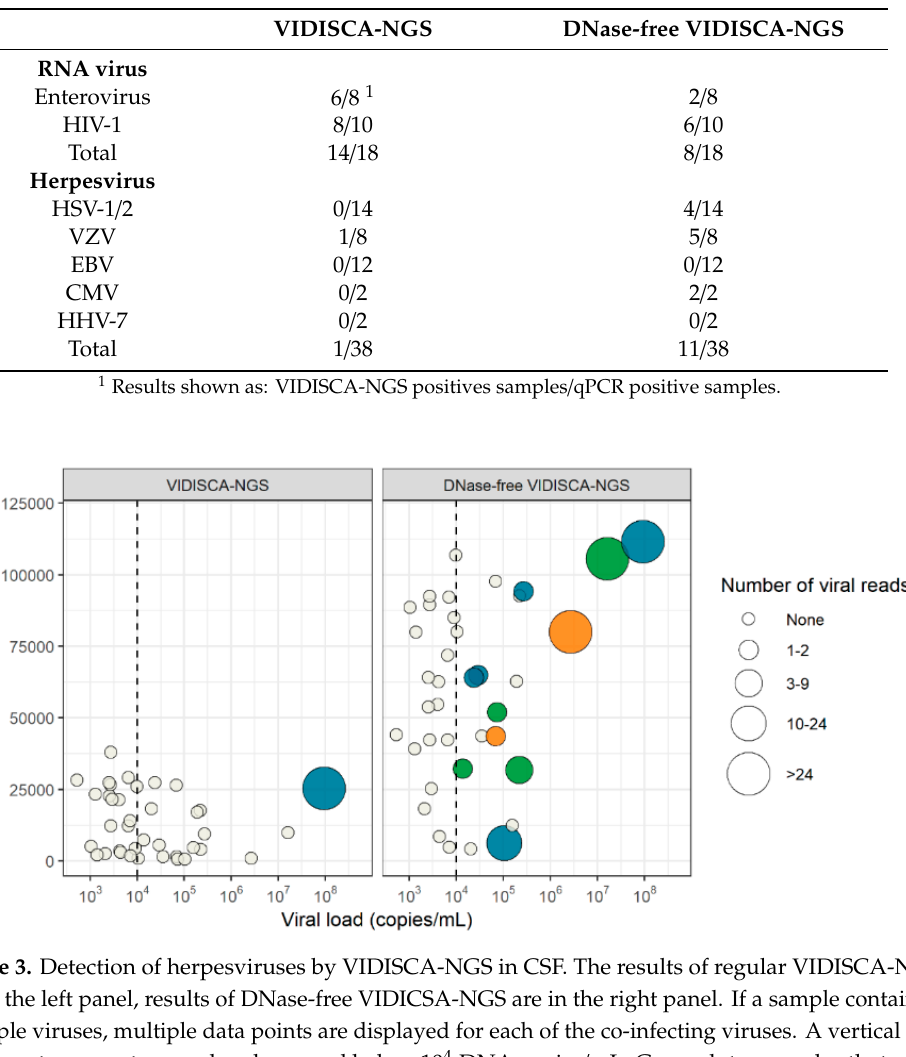
Table 2. Performance of VIDISCA-NGS to detect viruses compared to quantitative polymerase chain reaction (qPCR) in CSF.